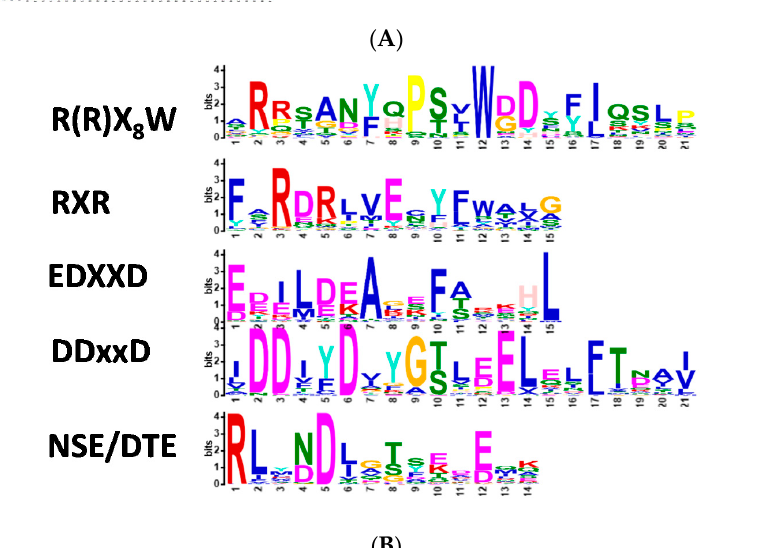
Figure 3. The amino acid sequences of the predicted motifs in TPS proteins. ( A ) Twenty-five classical motifs in TPS proteins were analyzed using the MEME tool. The width of each motif ranges from 6 to 50 amino acids. The font size represents the strength of conservation. ( B ) The amino acid sequences of five highly conserved motifs in TPS proteins.